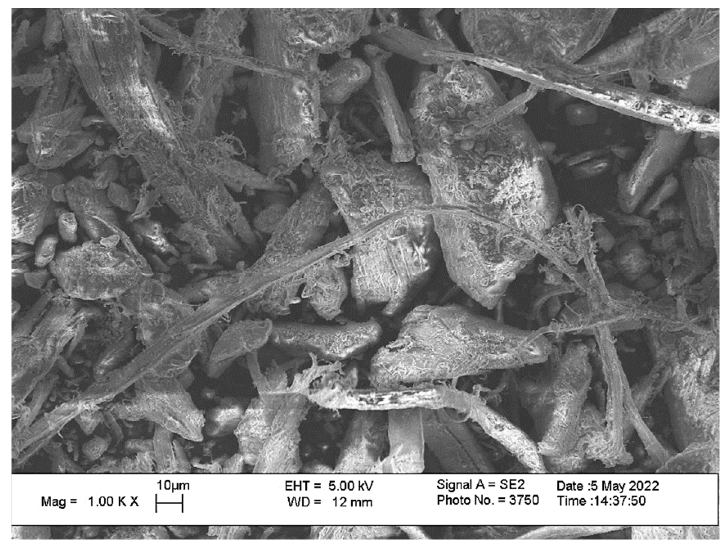
Figure 3. Micrograph of fish scale powder enriched with inorganic components prepared from the mixture of fish scales using high-speed grinding and vibration sieving, magnification ×1000.